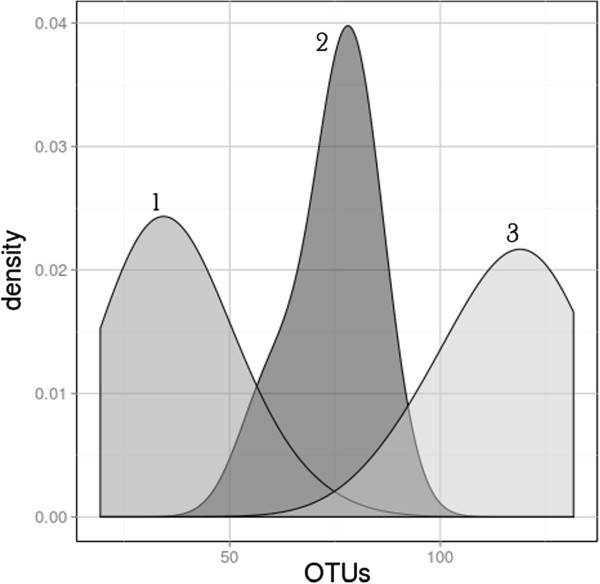
A density plot of observed OTU0.03 richness, rarefied to the 1,000-sequence level (n = 48), comparing the (1) northern (KEV, BEA, AND) locations, the (2) central (AC) location, and the (3) southern (AL, CH) locations. The vertical height of each grouping is the continuous probability that each group contains a sample with the given richness.